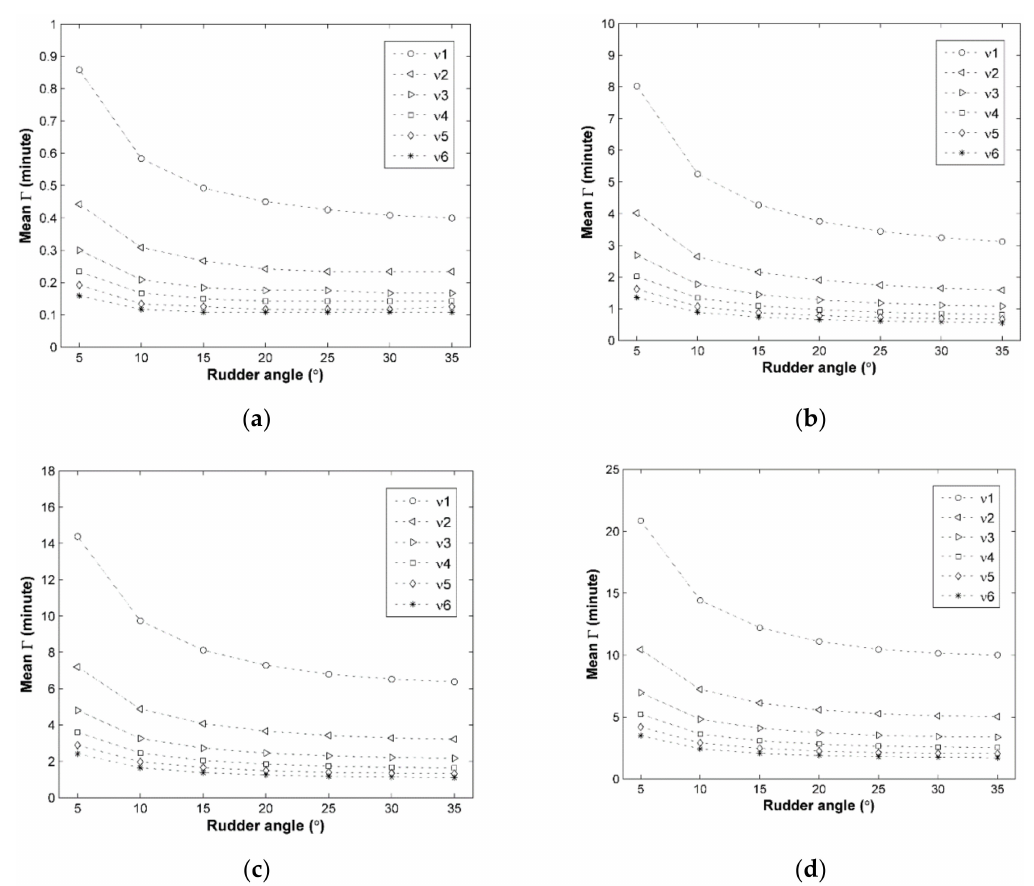
Figure 9. Average value of estimated critical latency for four scenarios: ( a ) Scenario 1; ( b ) Scenario 2; ( c ) Scenario 3; ( d ) Scenario